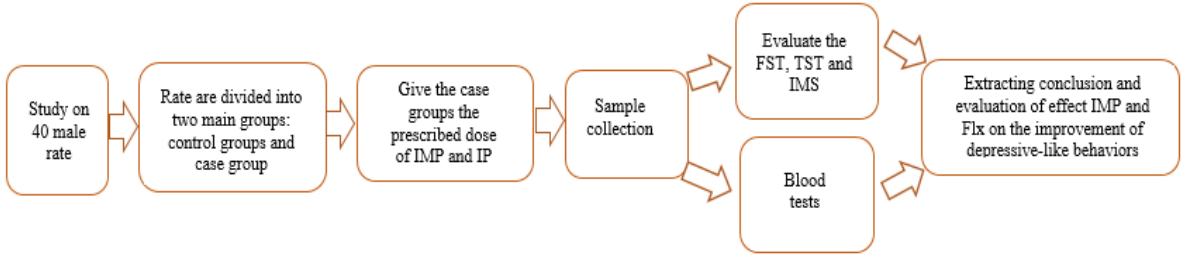
Fig. 2. Algorithm of the